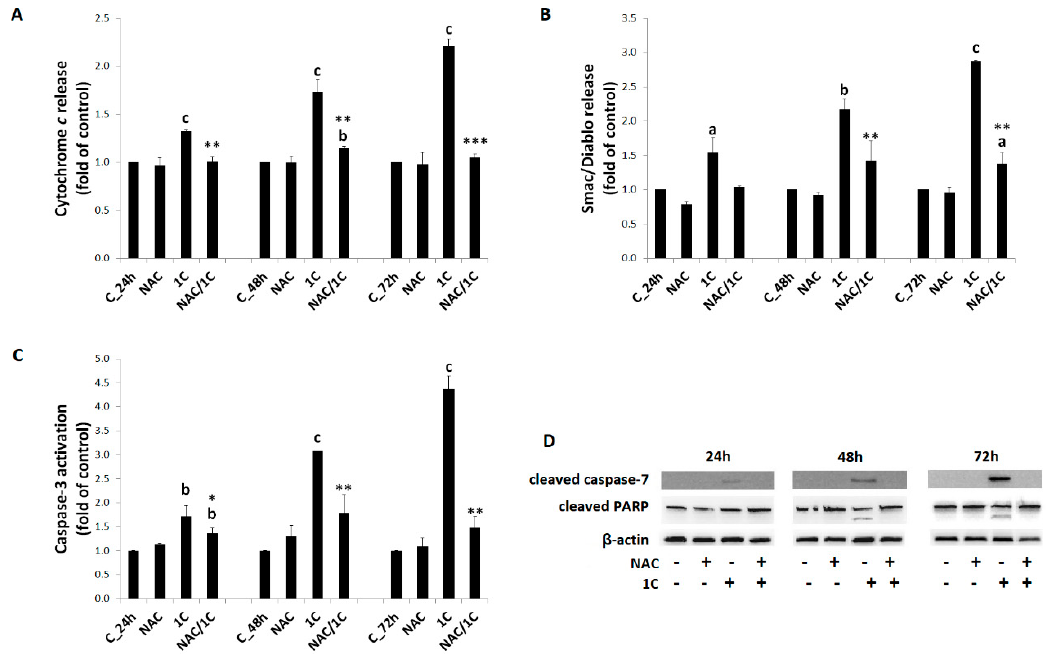
Figure 7. Mitochondrial apoptotic pathway alteration in 1C-treated and NAC / 1C-co-treated HCT116 cells represented by cytochrome c release ( A ), expression of Smac / DIABLO ( B ), and caspase-3 ( C ) or caspase-7 activation and PARP cleavage ( D ). Significantly different a p < 0.05, b p < 0.01, c p < 0.001 vs. untreated cells (control); * p < 0.05, ** p < 0.01, *** p < 0.001 vs. 1C.